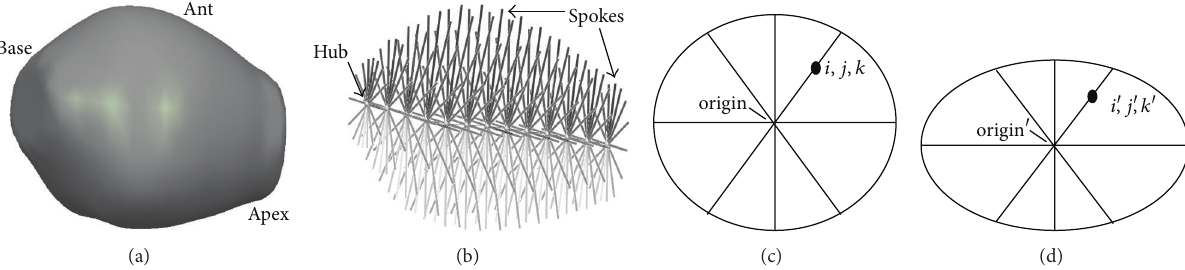
Figure5:(a)Lateralobliqueviewofthesurfaceofaprostatemodel.(b)Internaltubularskeletonshowingachainof13atoms,eachcomprising a hub and 16 spokes that touch the prostate surface. (c) and (d) Illustration of corresponding points in reference and deformed models. (c) Reference model with point at 𝑖,𝑗, 𝑘 . (d) Deformed model with corresponding point at 𝑖 󸀠 , 𝑗 󸀠 , 𝑘 󸀠 . The points are on the same spoke and they have the same fractional distance from the origin (atom hub).